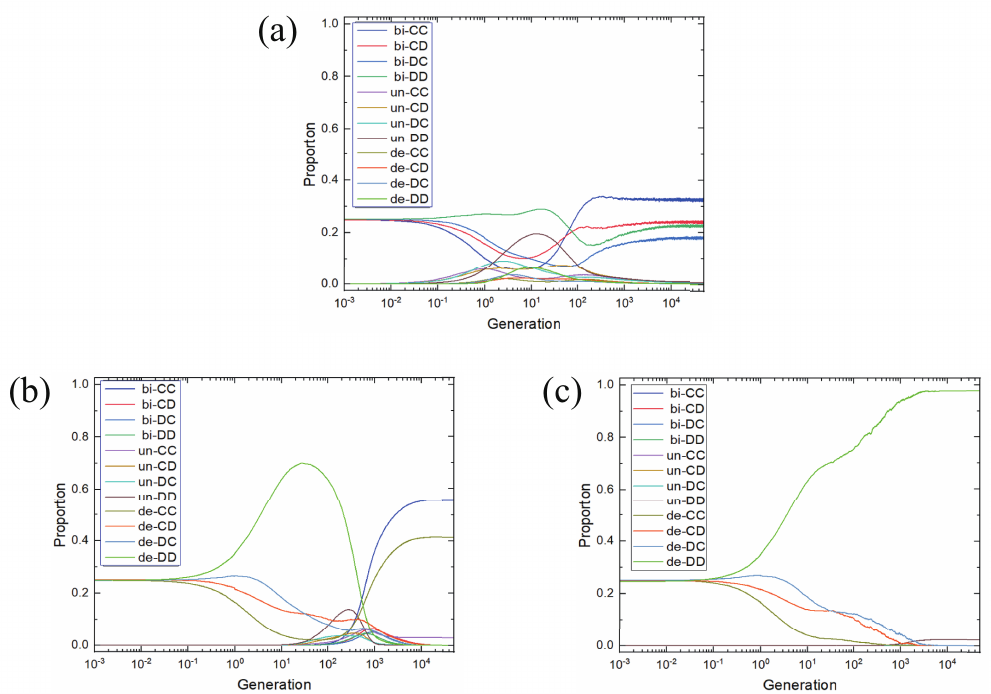
Figure 5. Time evolution of more specific different types of relationships between networks at β = 0.5. From subgraphs ( a – c ), the thresholds of influence τ are 0, 8, and 40, respectively. It should be noted that, due to the fact that the results obtained on both networks are qualitatively consistent, only the results obtained on bottom network are shown here. Other parameters are exactly the same as those in Figure